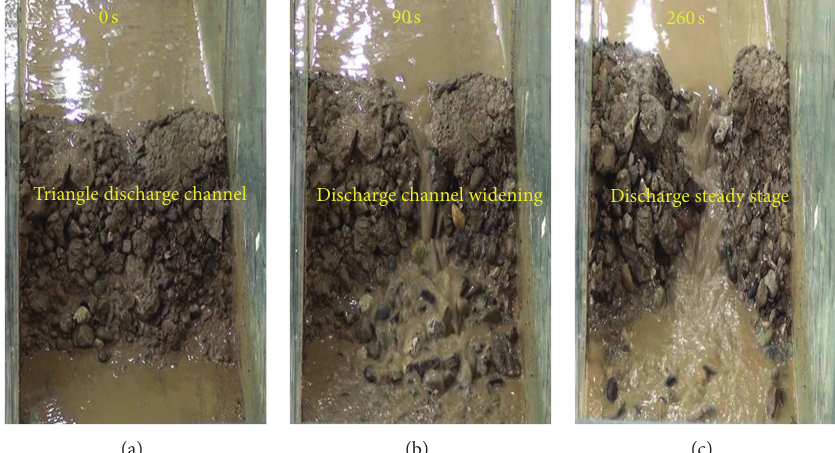
Figure 16: Process of dam break of a landslide dam with a triangular shaped discharge channel at different time intervals: (a) 0s (b) 90s and (c) 260